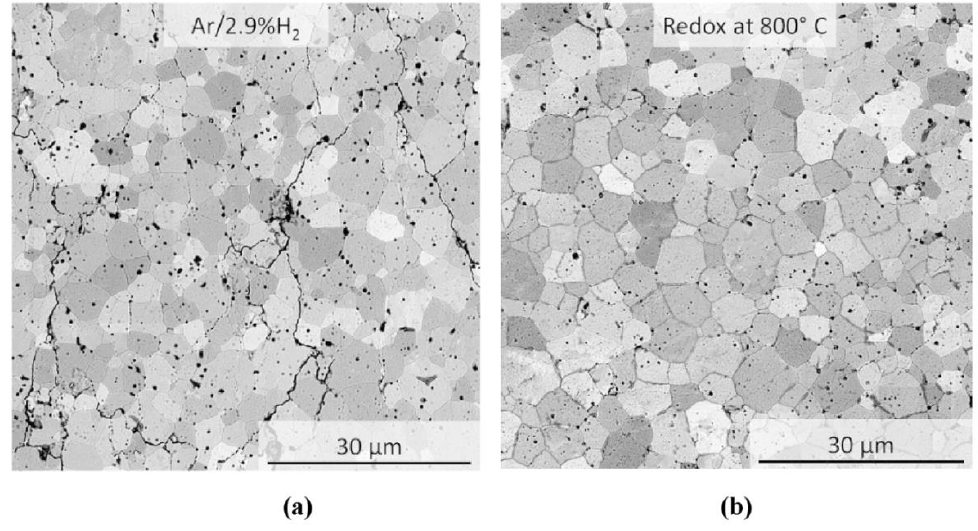
Figure 9. Micrographs of pressureless sintered samples: ( a ) cracks formation after sintering entirely in Ar-2.9%H 2 , ( b ) nearly crack-free structure after sintering in Ar-2.9%H 2 with subsequent re-oxidation.